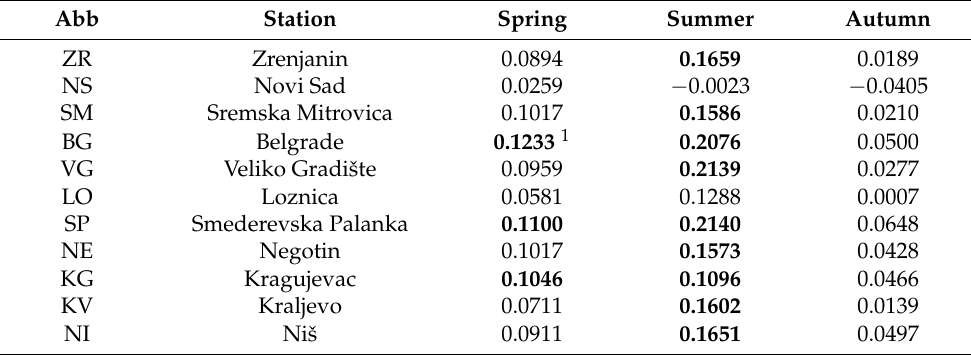
Table 3. Seasonal trend coefficients of SU for 11 stations in Serbia from 1949 to 2018. Abb Station